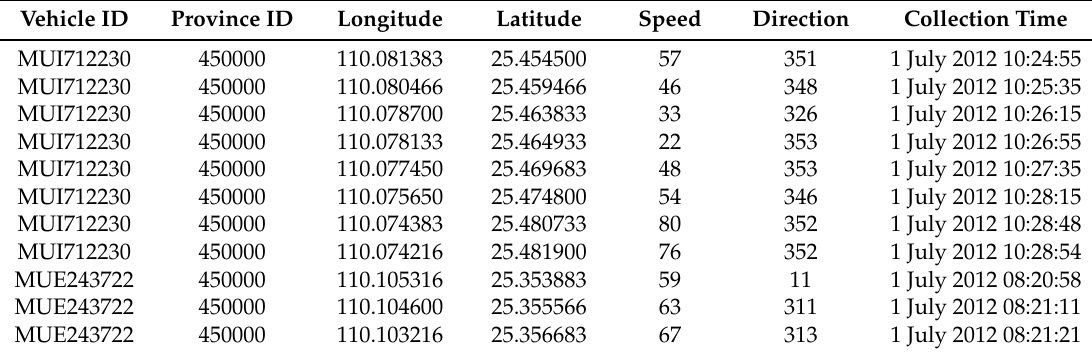
Table 1. Part of the GPS tracking data in Lijiang River Basin.